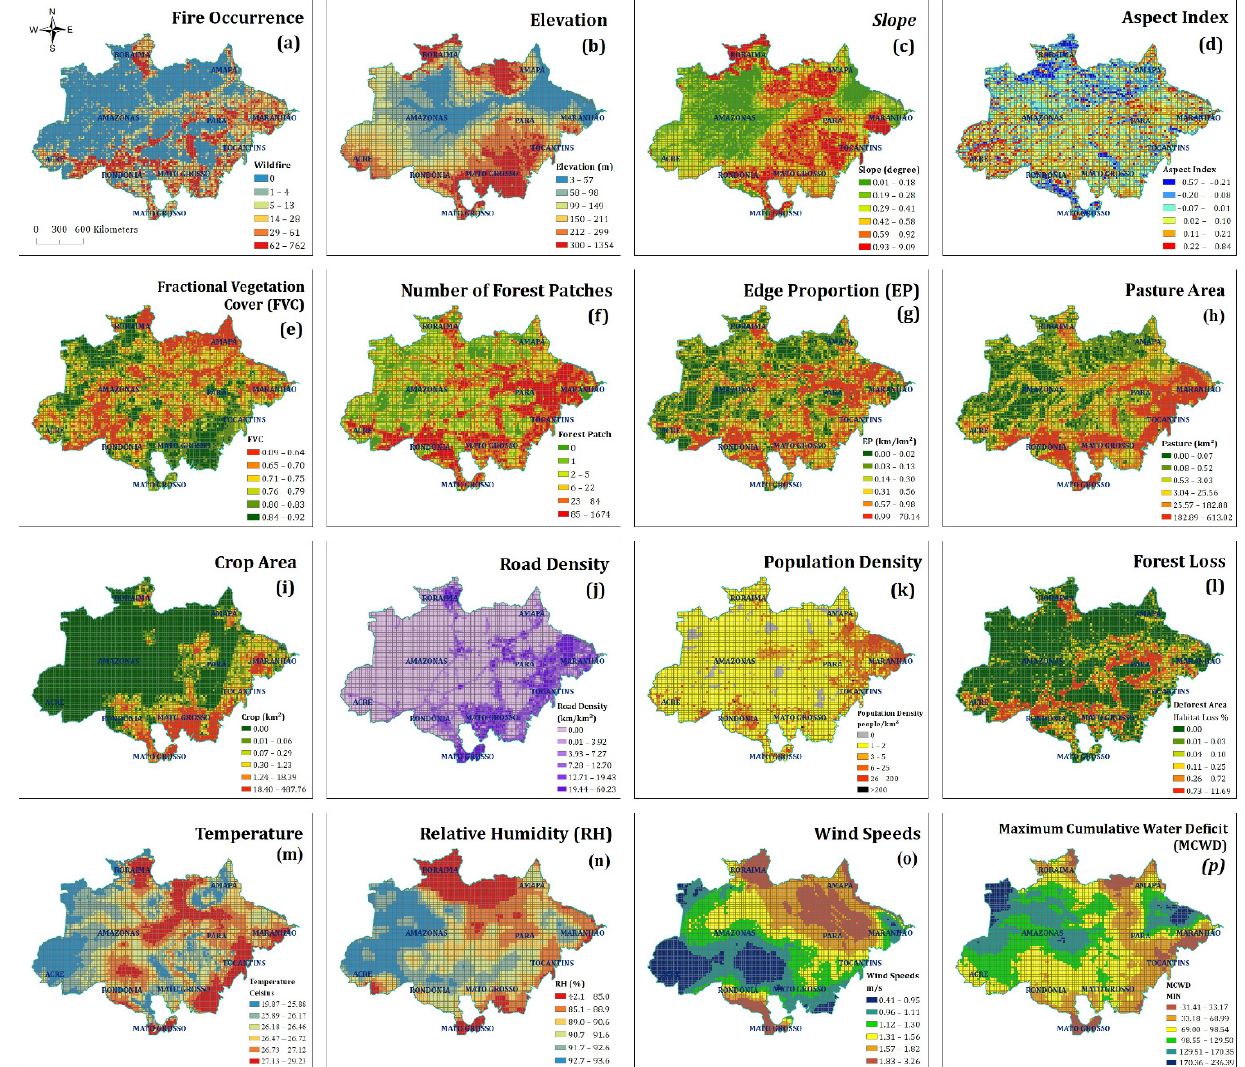
Figure 3. Spatial distribution of dependent and explanatory variables. ( a ) Wildfire count, ( b ) Eleva- tion, ( c ) Slope, ( d ) Aspect, ( e ) FVC, ( f ) Number of Forest Patches, ( g ) Edge Proportion, ( h ) Pasture Area, ( i ) Crop Area, ( j ) Road Density, ( k ) Population Density, ( l ) Forest Loss, ( m ) Temperature, ( n ) Relative Humidity, ( o ) Wind Speed, ( p ) Maximum Cumulative Water Deficit.